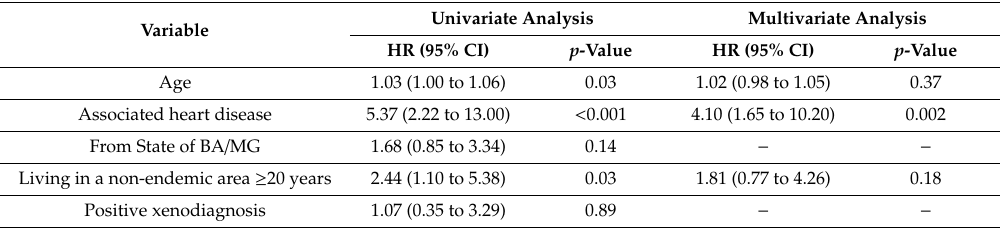
Table 3. Univariate and multivariate Cox regression model for progression from the indeterminate to cardiac